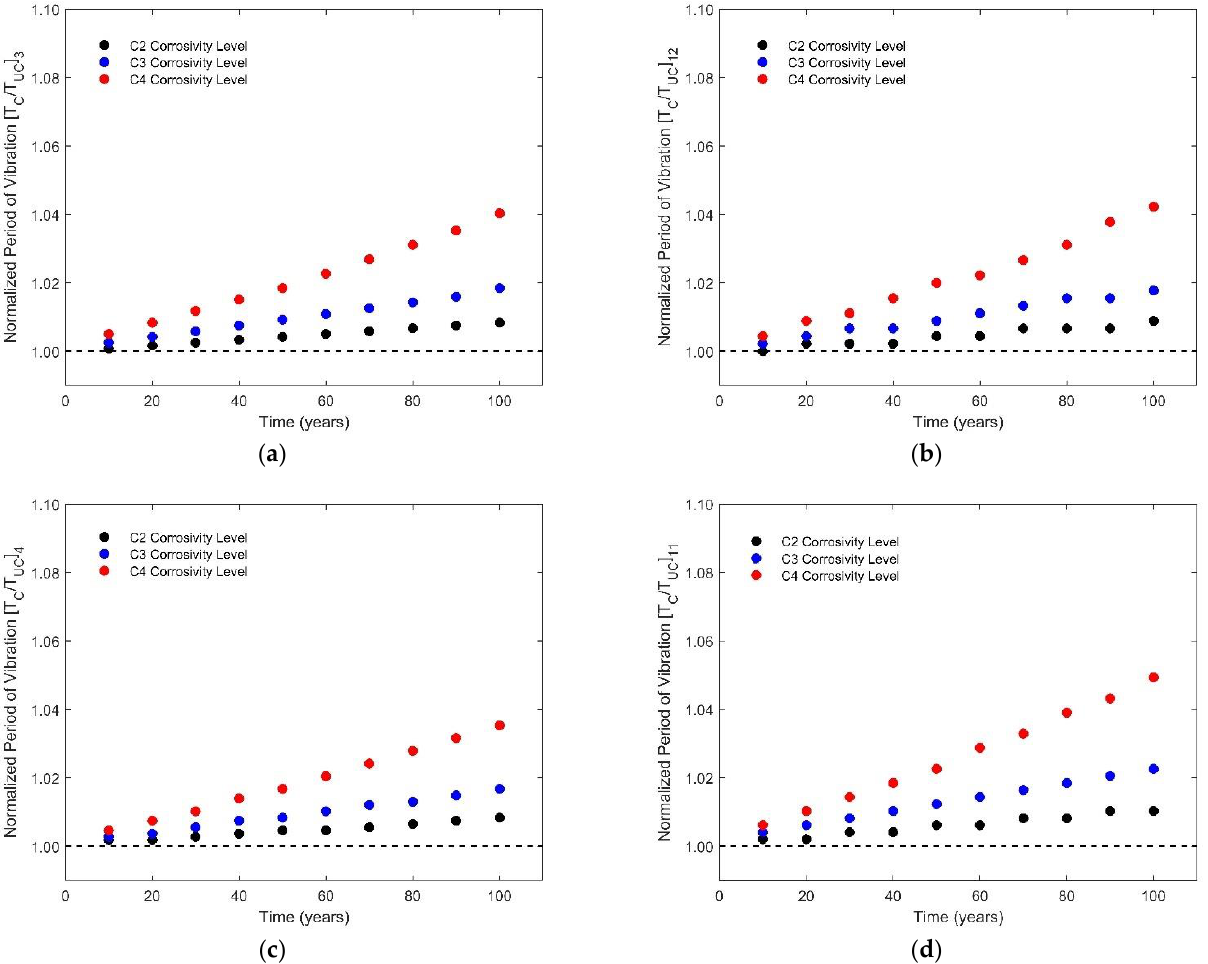
Figure 10. Normalized period of vibration with respect to exposure time (effect of corrosion on web only) for: ( a ) mode no. 3 in Y direction; ( b ) mode no. 12 in Y direction; ( c ) mode no. 4 in X direction; ( d ) mode no. 11 in X direction. (T C and T UC are for corroded and uncorroded cases respectively).